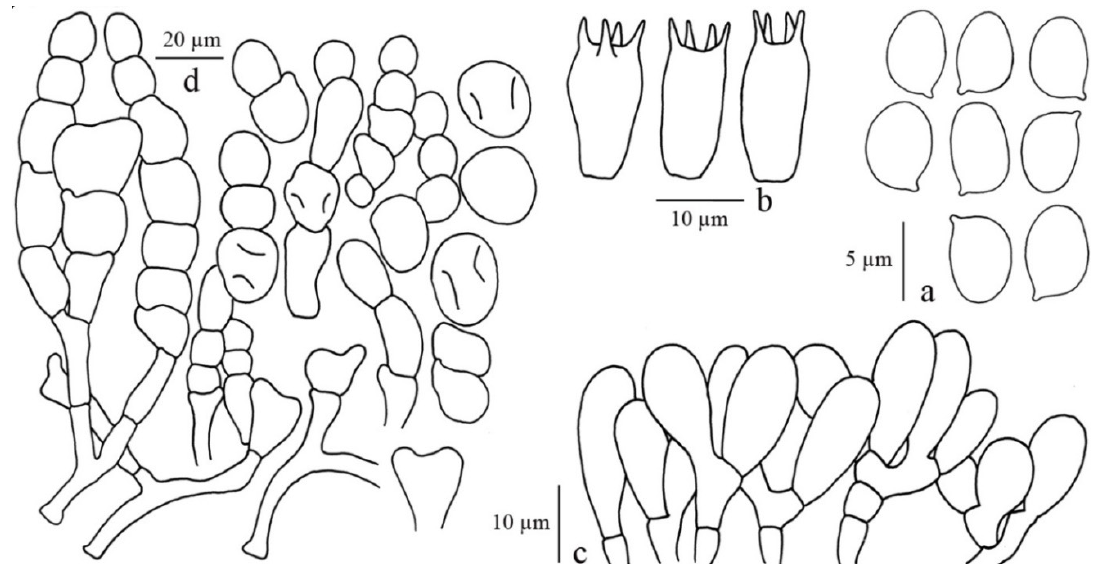
Figure 28. Microcharacters of Xanthagaricus purpureosquamulosus (MFLU 19-2354, holotype). ( a ) basidiospores. ( b ) basidia. ( c ) cheilocystidia. ( d ) pileus covering.